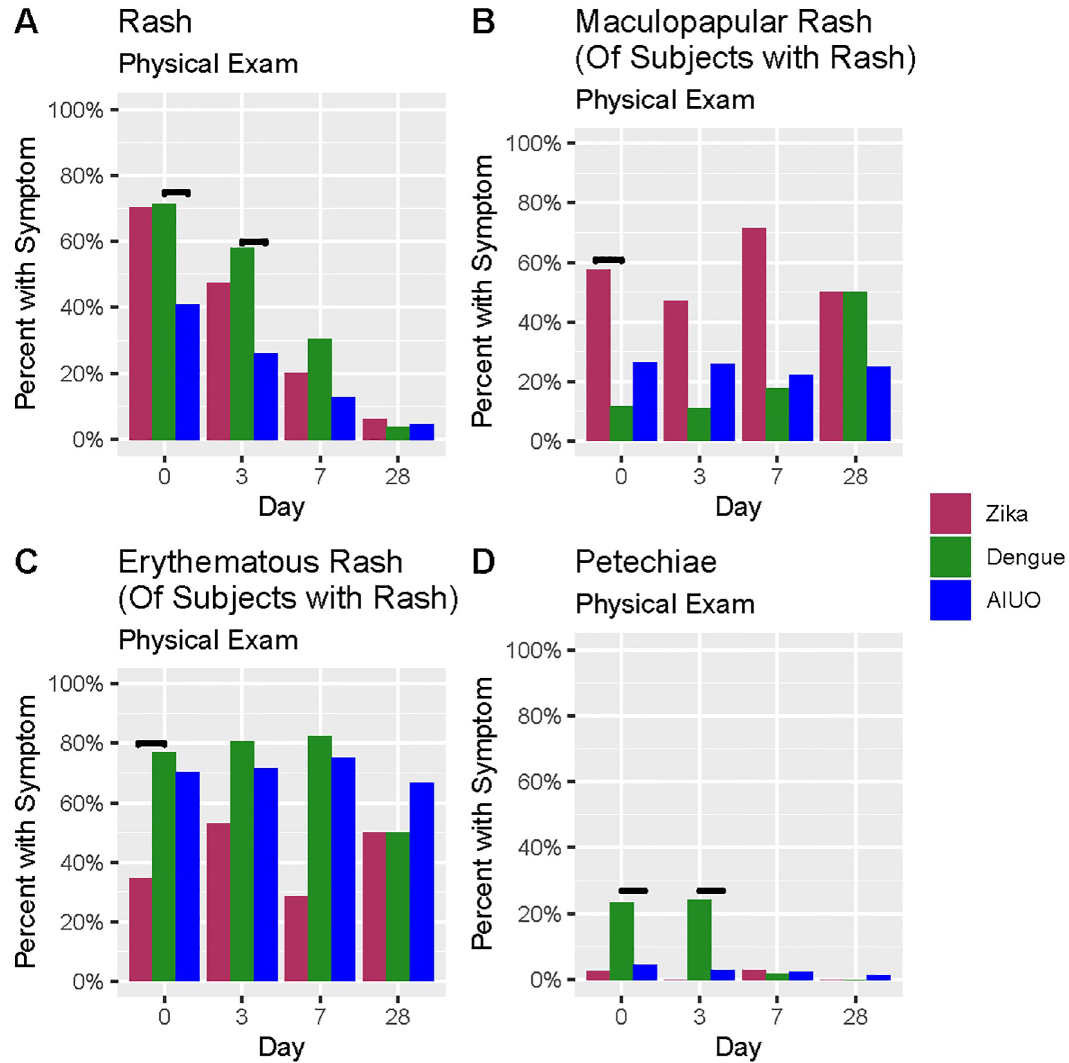
Fig 2. Comparison of findings at physical exam among patients with confirmed Zika, dengue infections, and AIUO. Darker lines above bars indicate statistically significant comparisons.